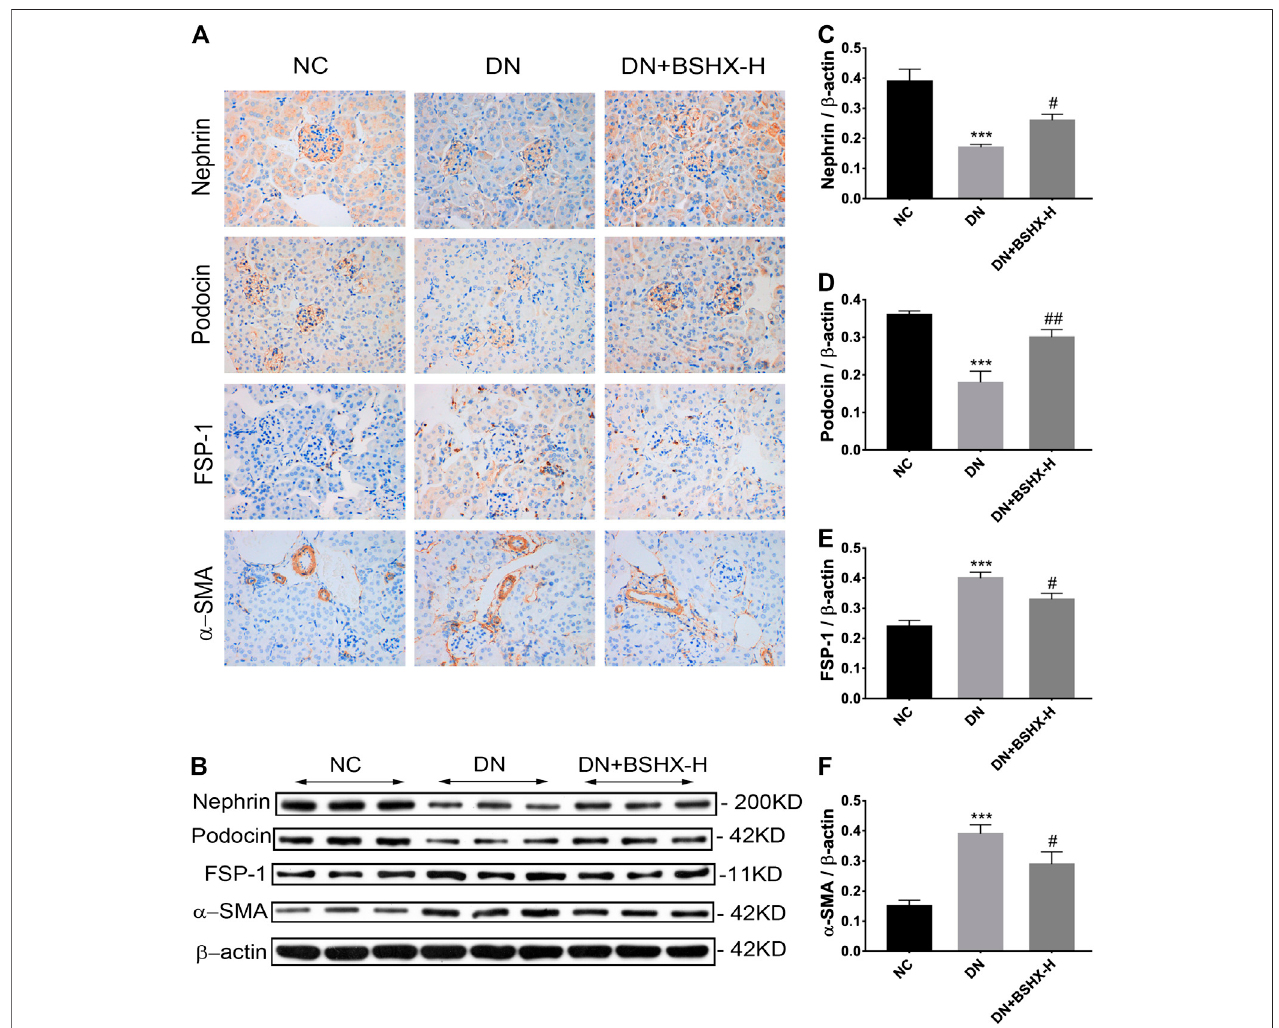
FIGURE 6 | Effect of BSHX decoction on nephrin, podocin, FSP-1, and α -SMA levels in DN mouse kidney. (A) IHC staining of the kidney ( × 400) to analyze the expression levels of nephrin, podocin, FSP-1, and α -SMA. (B) Western blot assays to evaluate the expression levels of nephrin, podocin, FSP-1 and α -SMA. Beta-actin was measured as the loading control. (C) Quantitative analysis of the relative expression levels of nephrin. (D) Quantitative analysis of the relative expression levels of podocin. (E) QuantitativeanalysisoftherelativeexpressionlevelsofFSP-1. (F) Quantitativeanalysisoftherelativeexpressionlevelsof α -SMA. n (cid:1) 5micepergroup. All data are expressed as means ± SEM. * p < 0.05, ** p < 0.01, *** p < 0.001 vs. the NC group; # p < 0.05, ## p < 0.05, ### p < 0.001 vs. the DN model group.